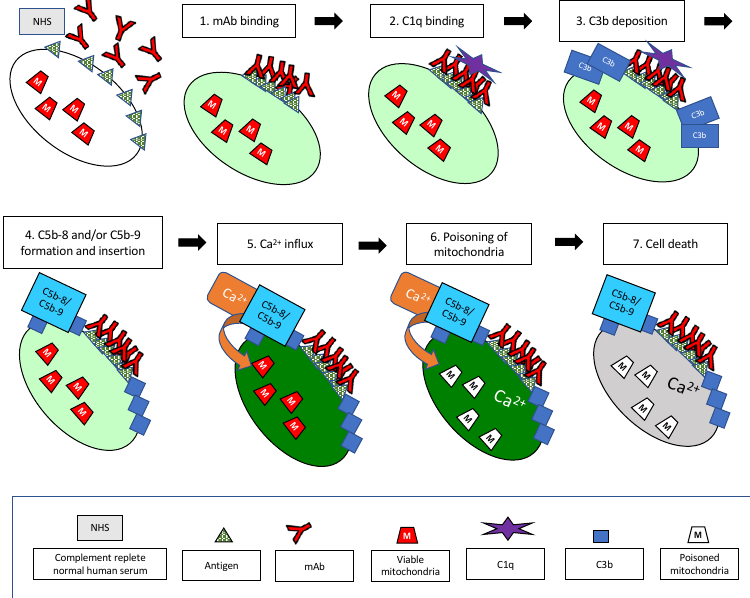
Figure 16. Simplified schematic illustrating the key steps in the CDC reaction that are described in this review. The reaction takes place at 37 °C in 50% NHS, and the mAb is at a concentration of 10 μg/mL. The target cell is internally labeled with Fluo-4. The pale green color of the cell illustrates the low, physiological levels of cytoplasmic Ca +2 . ( 1 ). Multiple mAbs bind to the cell in proximity, ideally forming hexamers. ( 2 ). C1q then binds to the mAb hexamers on the cell. ( 3 ). Downstream, C3b is deposited on the cell, closely associated with bound mAb. ( 4 ). After sufficient C3b has deposited on the cell, C5b is generated, and C5b-8 and/or C5b-9 assemble close to the sites of C3b deposition. ( 5 ). The pores formed in the plasma membrane by C5b-8 and/or C5b-9 allow the influx of large amounts of Ca 2+ and the cell turns bright green (the live, transition-state intermediate). ( 6 ). Soon thereafter, the Ca 2 in the cell penetrates and poisons the mitochondria. ( 7 ). This is rapidly followed by cell death. Coincident with cell death, most of the Fluo-4 leaks out of the cell. Not shown are the TNTs that are generated in the cells soon after the initial influx of Ca 2+ , during steps ( 5 ) and ( 6 ). Approximate times for these events are provided in Table 1, and all of the reactions are fast. The hexamer-forming mAbs and C1q are bound to the cell in less than 1 min, and the cells are killed in less than 2 min. 12. Patents R.P.T. and M.A.L. are listed as co-inventors on a patent that describes the use of hexamer- forming antibodies. Author Contributions: R.P.T. and M.A.L. wrote and edited this manuscript. All authors have read and agreed to the published version of the manuscript. Funding: No funding provided for the preparation of this manuscript. Acknowledgments: The work described herein could never have been accomplished without the enthusiastic participation of the following individuals: Paul Beum, Frank Beurskens, Ricard Burack, Erika Cook, Adam Kennedy, Joanne Lannigan, Monica Liu, Paul Parren, Andrew Pawluczkowycz, Elizabeth Peek, Michael Pokrass, Michael Solga, Janine Schuurman, Jillian Tupitza, Jan van de Winkel, and Clive Zent. Conflicts of Interest: RPT and MAL have licensed mAbs 3E7 and 7C12 for commercial use through the University of Virginia Licensing and Ventures Group.